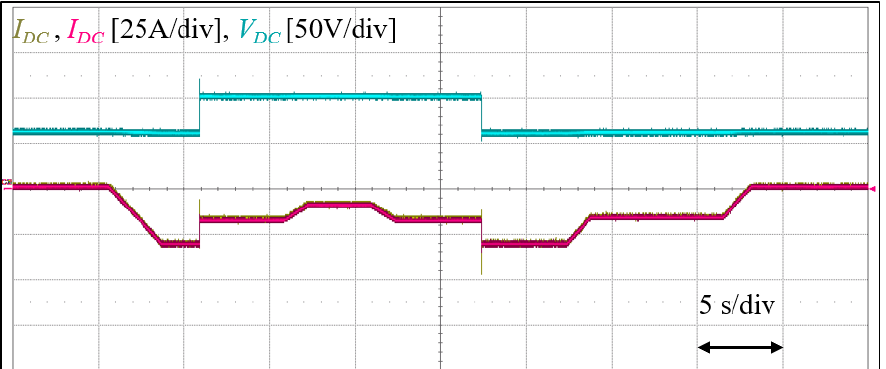
Figure 15. Experimental result of overall steady-state and transient stability